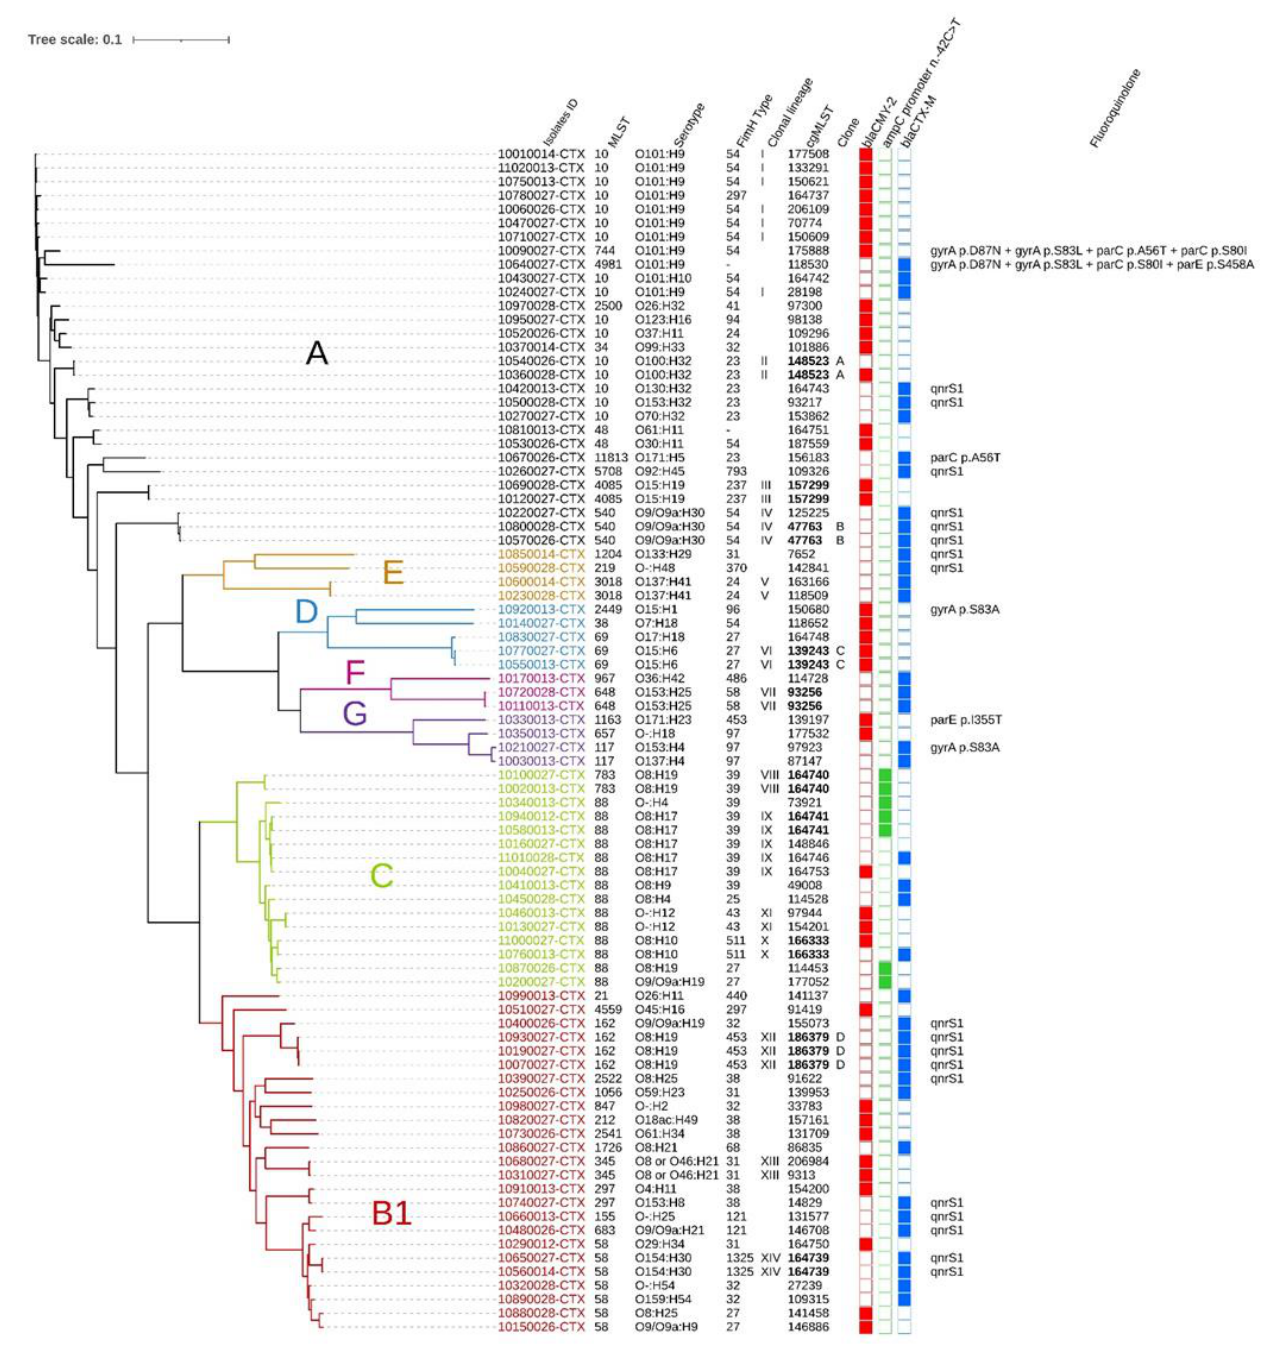
Figure 3. Phylogenetic tree created by CSIPhylogeny from the Center for Genomic Epidemiology by E. coli ( n = 86). Single nucleotide polymorphisms (SNPs) were analysed and modified with the Itol online platform. Each branch with a bootstrap value <1 was deleted. The letters and their corresponding colour to the left are the Clermont phylogroup mash group created by the clermontyping online platform. Isolate ID: the first four digits of the isolate ID number are the farm identification (example: 10890013 = farm #89) and the last four digits are the sample type and the sample period (0012 = cow spring 2017, 0013 = calf spring 2017, 0014 = manure pit spring 2017, 0026 = cow fall 2017, 0027 = calf fall 2017, and 0028 = manure pit fall 2017). The definition of clonal isolates was 12 or fewer SNP differences from each other. A clonal lineage comprises isolates with the same sequence type (ST), serogroup, phylogroup, and fim H gene.